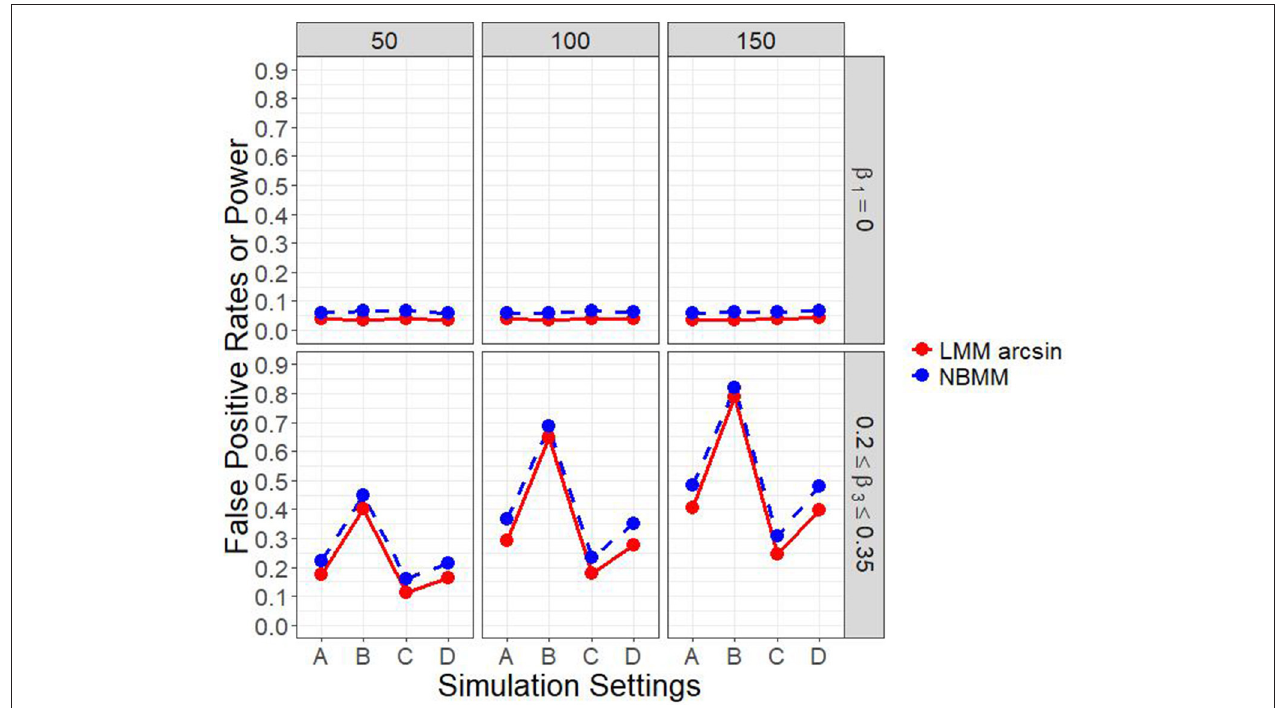
FIGURE 1 | Empirical power of interaction term and false positive rates of main effect in all four simulation